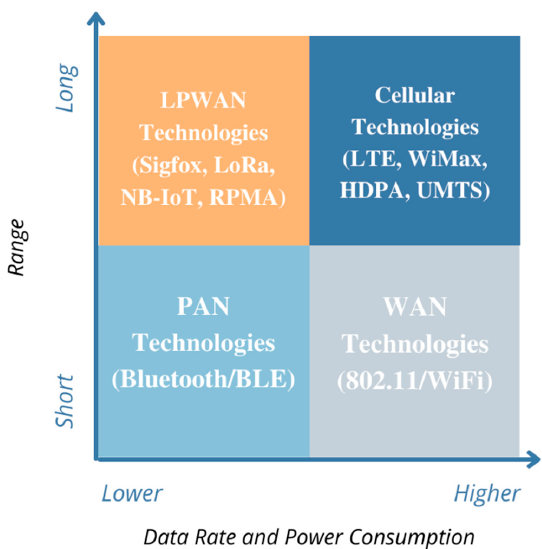
Figure 1. Comparison of wireless communication technologies. LPWAN technologies consume less battery power while working over long ranges.